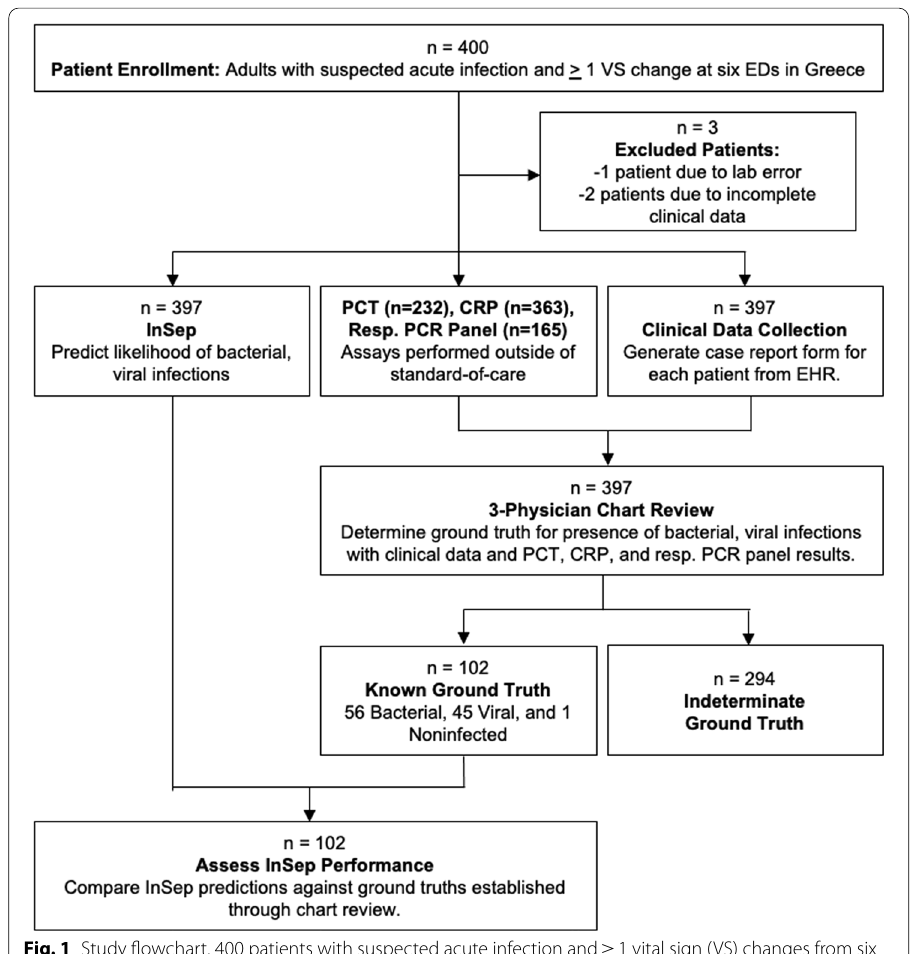
Fig. 1 Study flowchart. 400 patients with suspected acute infection and EDs in Greece were enrolled. Three physicians used electronic health records (EHRs) data alongside results from PCT, CRP, and respiratory syndromic panels to establish ground truths for the presence of bacterial and viral infections. InSep performance was compared to ground